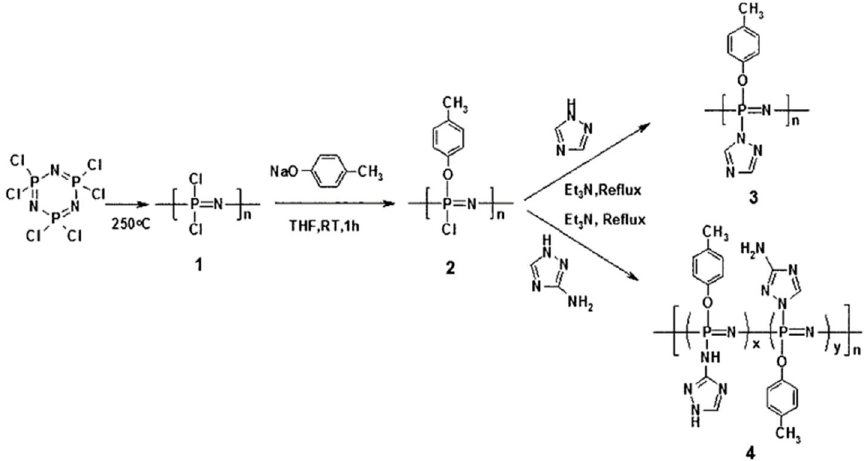
Figure 3. The synthetic pathway of the membrane. [101].